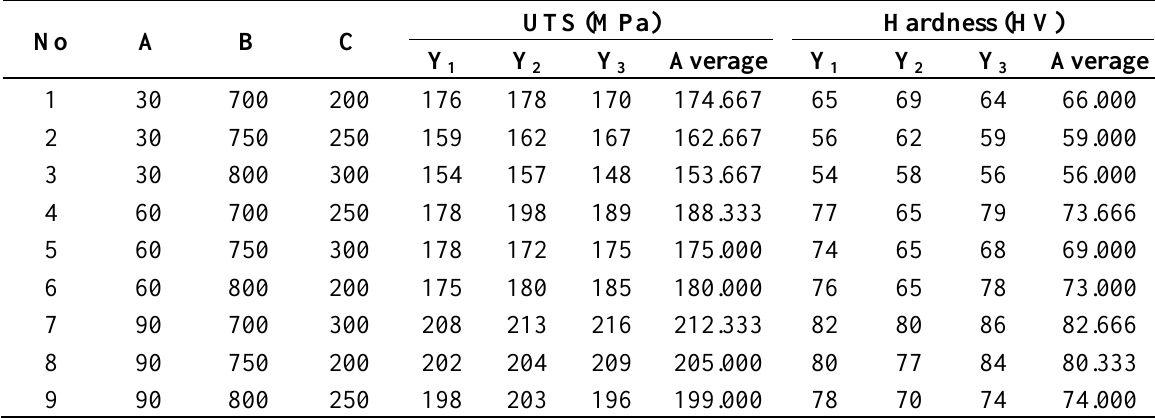
orthogonal array experiments. 9